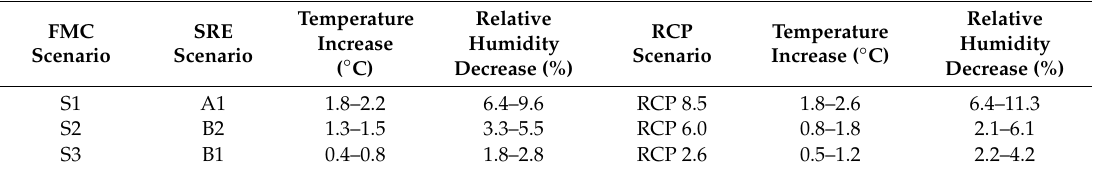
Table 2. New fuel moisture content (FMC) scenarios created based on Special Report on Emission (SRE) and Representative Concentration Pathway (RCP)